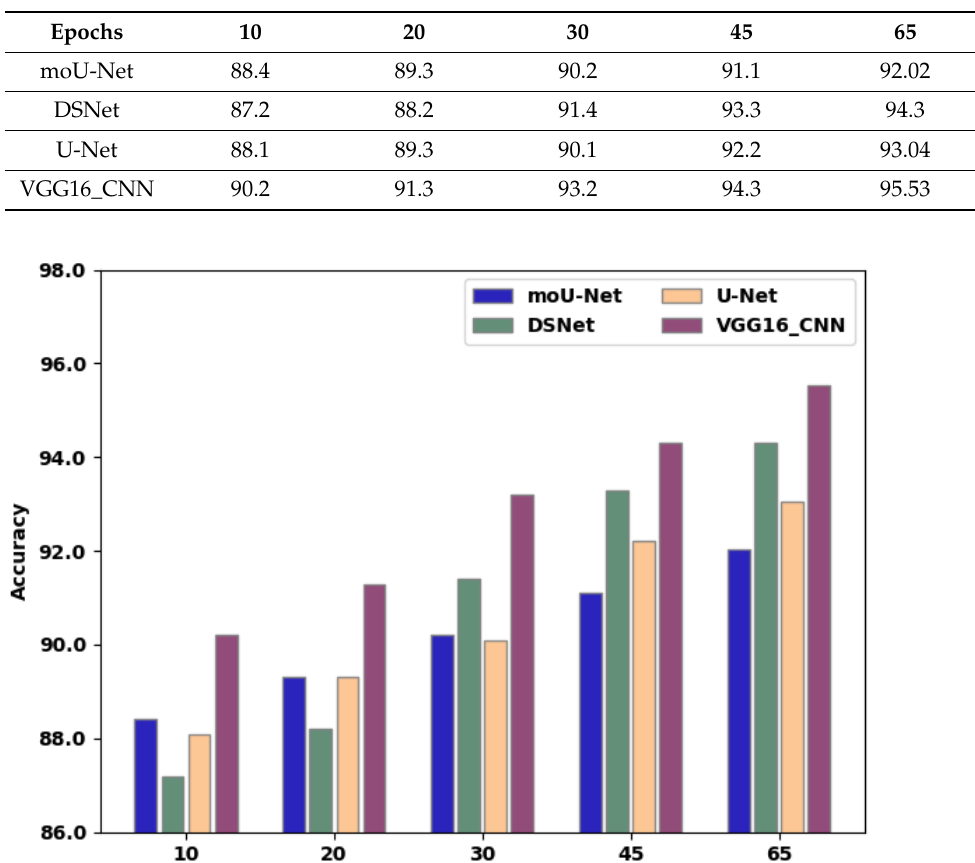
Table 2. Comparison of accuracy over various epochs between existing techniques and the proposed methodology.